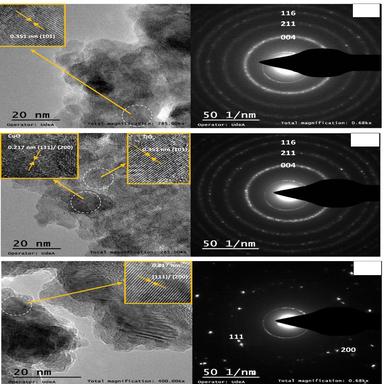
HRTEM images and SAED pattern: (a) TC0; (b) TC2; (c) TC7.